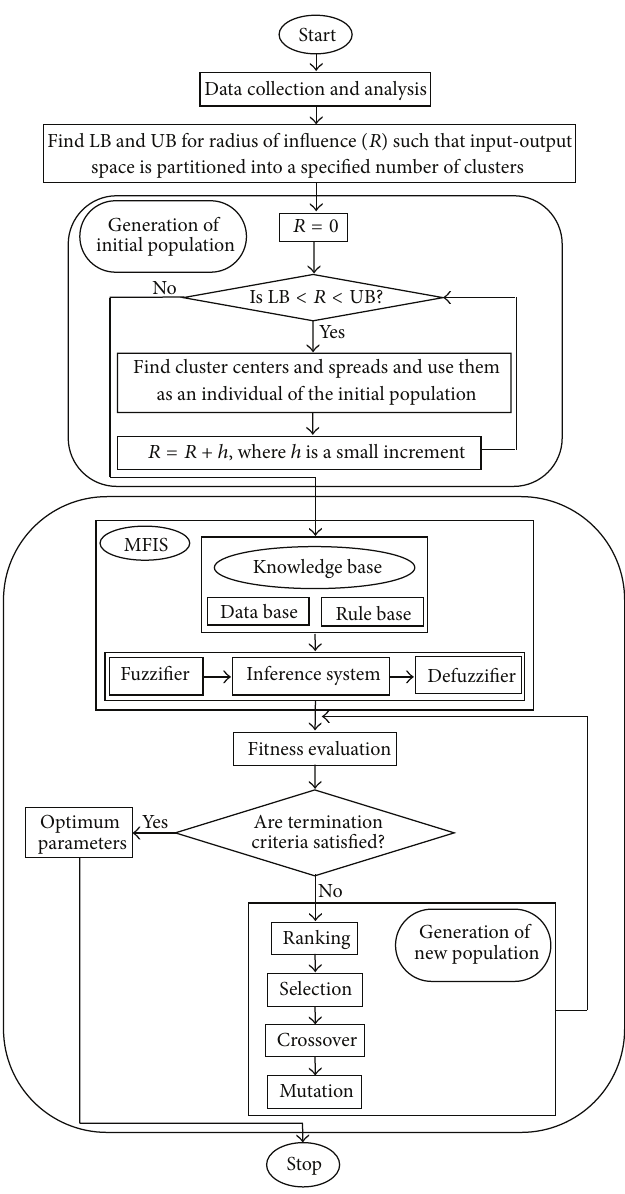
Figure 2: Flowchart for the suggested method.